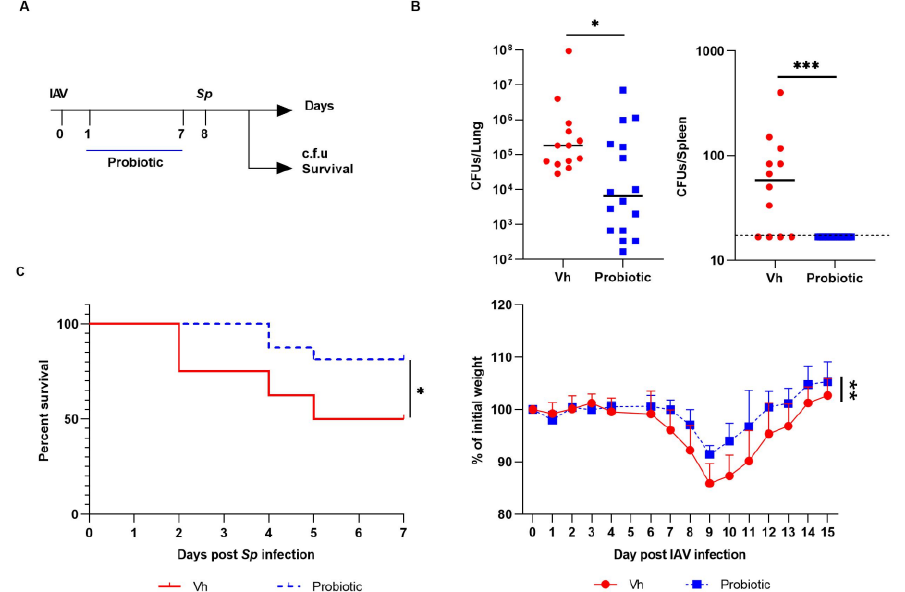
Figure 4. Effect of B. faecis DSM33383 supplementation during IAV infection on secondary Streptococcus pneumoniae infection. ( A ) Schematic representation of the double infection system. IAV-infected mice (8 d.p.i.) were infected with S.p (1 × 10 6 CFU). IAV-infected mice were gavaged or not with B. faecis DSM33383 (5 × 10 6 CFU/200 μ L) at 2 d.p.i. until 7 d.p.i. ( B ) The number of bacteria was determined in lung (left) and spleen (right) 30 h after the bacterial challenge ( n = 13–16, two pooled experiments shown). ( C ) The survival (left) and body weight evolution (right) (in % initial body weight) of doubly infected animals, treated or not, were monitored ( n = 16, two pooled experiments shown). Significant differences were determined using the Mann–Whitney U test ( B , C ). Mice sur ‐